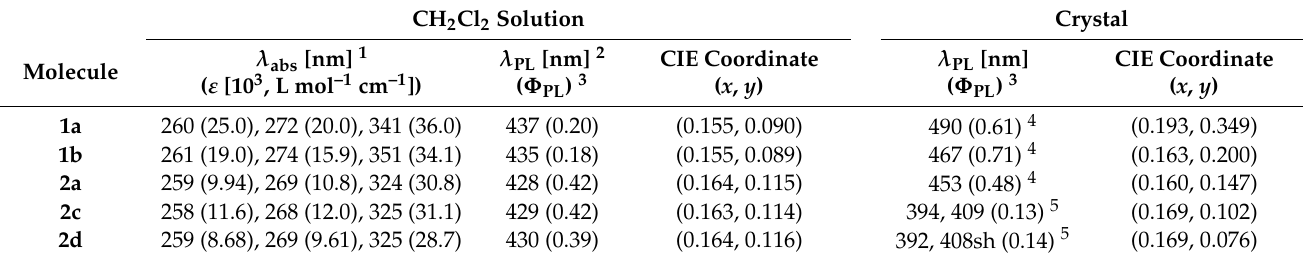
sphere. 4 Excitation wavelength: 310 nm. 5 Excitation wavelength: 350